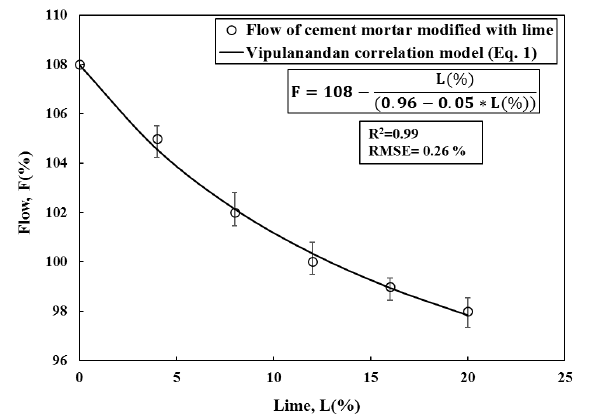
Figure 9: Relationship between lime content and of flowability of cement